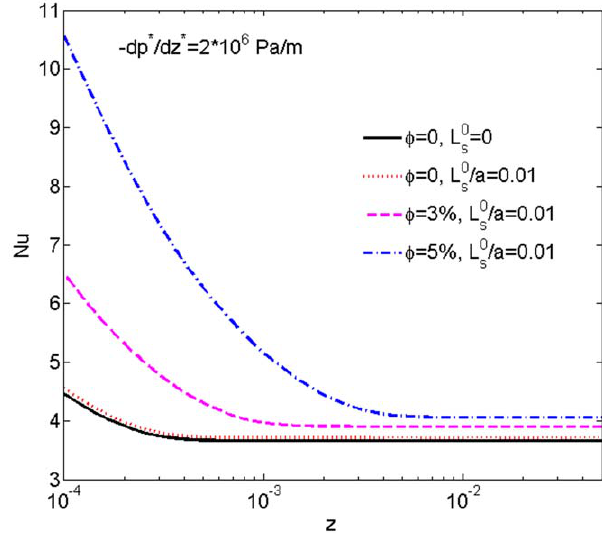
Figure 6. The heat transfer rates corresponding to different nanoparticle volume fractions. The heat transfer curves are calculated for w ~ 0, 3% and 5% with a fixed dimensionless slip length L 0 = a ~ 0.01 and pressure gradient { dp (cid:2) = dz (cid:2) ~ 2 | 10 6 Pa/m, showing s the effect of nanoparticle volume fraction on the heat transfer rate; the non-slip curve for w ~ 0 is also plotted for revealing the slip effect.